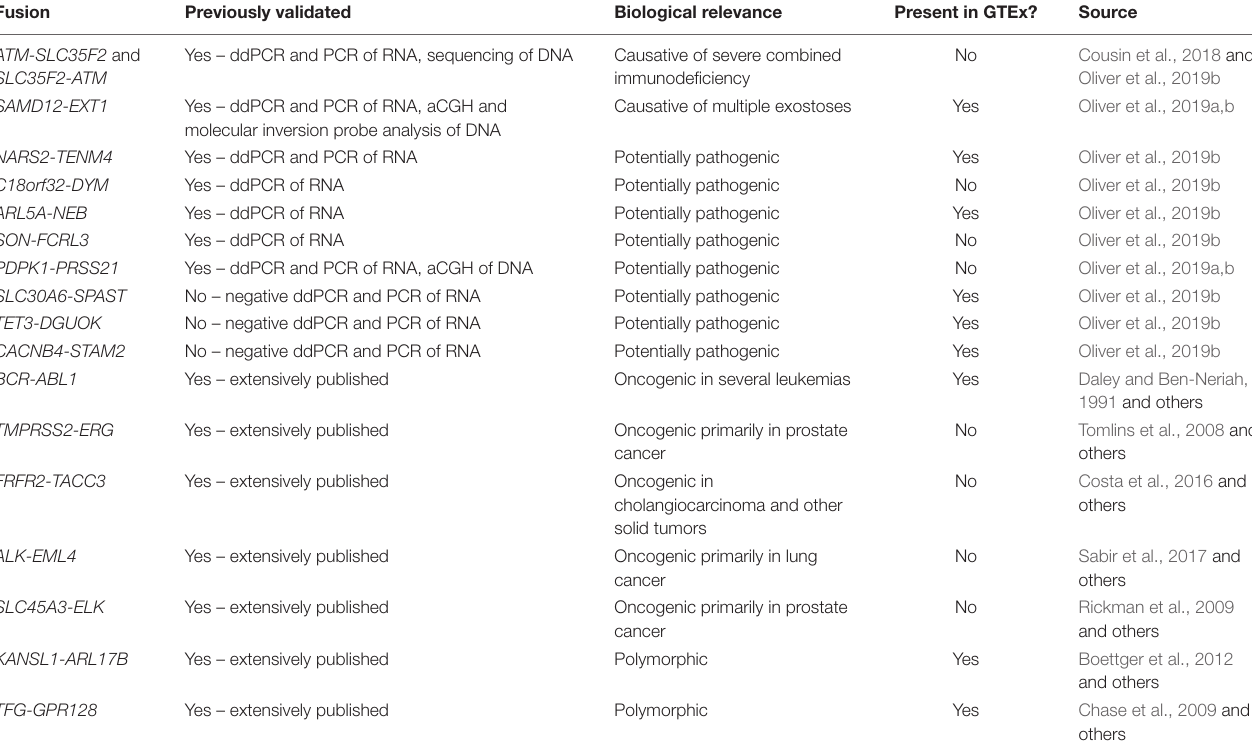
TABLE 1 | Fusion candidates assessed for presence in the GTEx normal tissue fusion database.